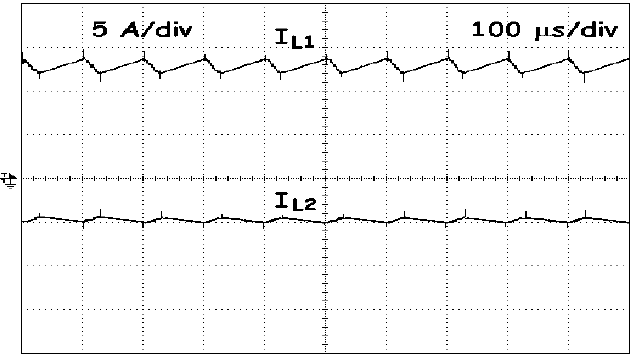
Figure 21. Experimental results for the voltage across the power switch S W in boost mode.